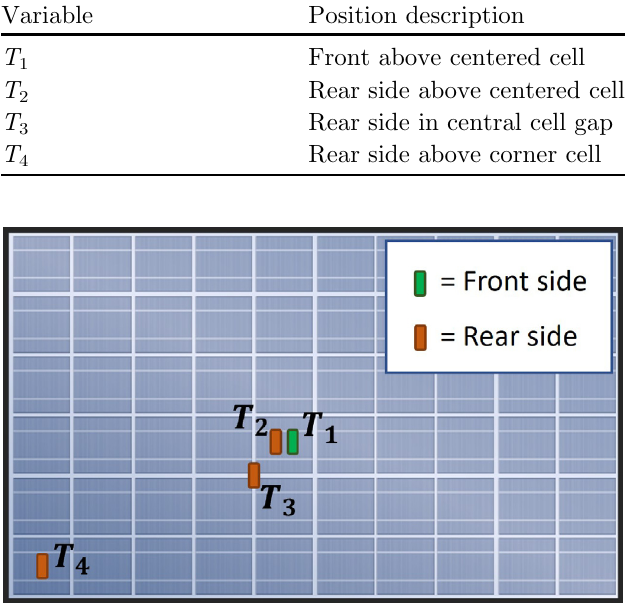
Fig. 2. Schematic showing the positions of the T -thermocouples to survey the module temperature. Including the used measure- ment point names, T 1 to T 4